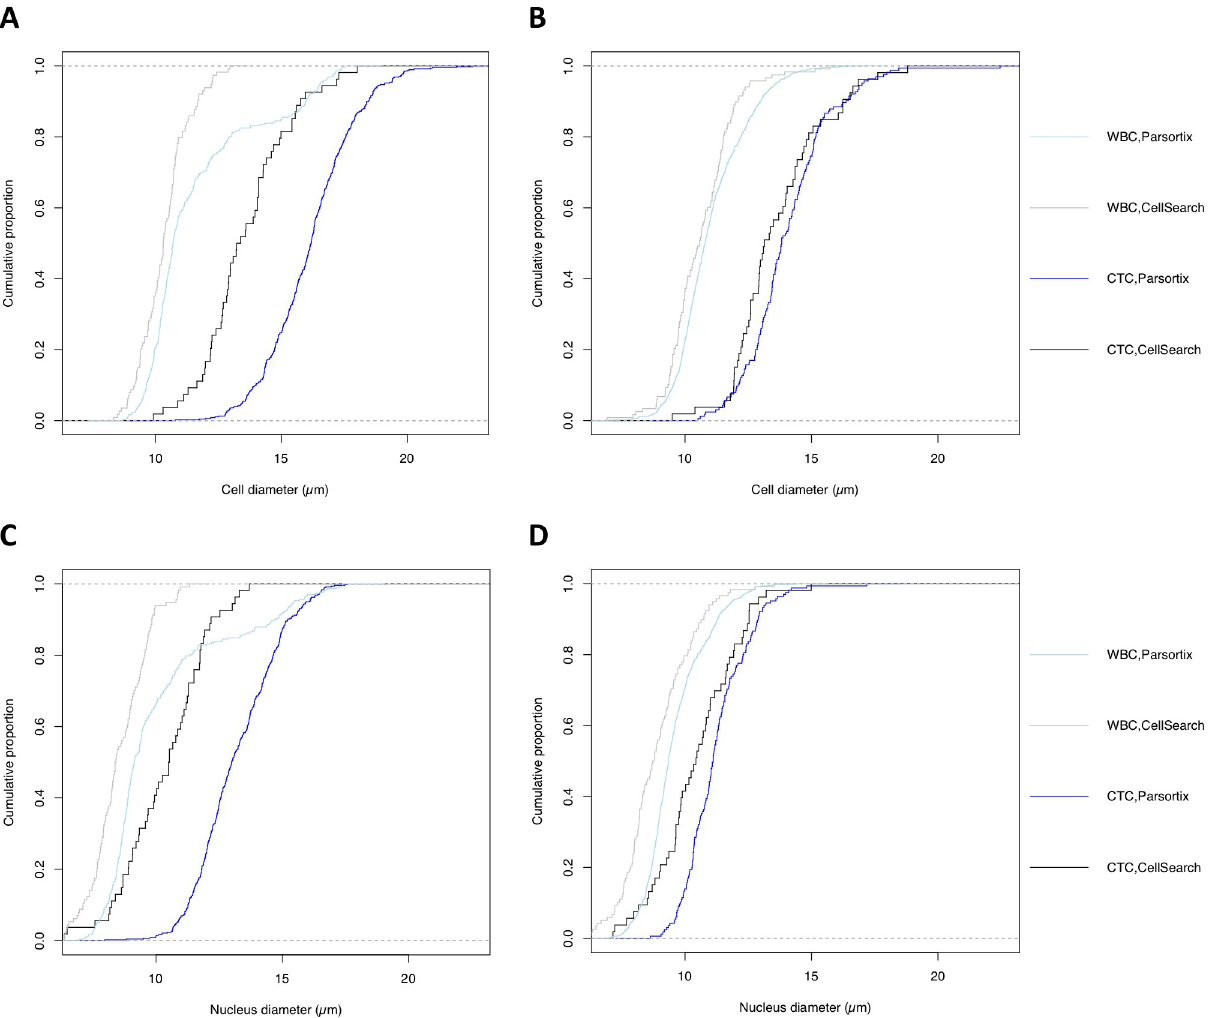
Fig 2. Comparison of cell-and nucleus diameter per enrichment platform and cell type. Empiric cumulative distribution curves for cell-and nucleus diameters for cell lines, WBCs and enrichment platform. A: Comparison cell diameter in OE33 cell line. B: Comparison of cell diameter in OE19 cell line. C: Comparison nucleus diameter in OE33 cell line. D: Comparison of nucleus diameter in OE19 cell line.